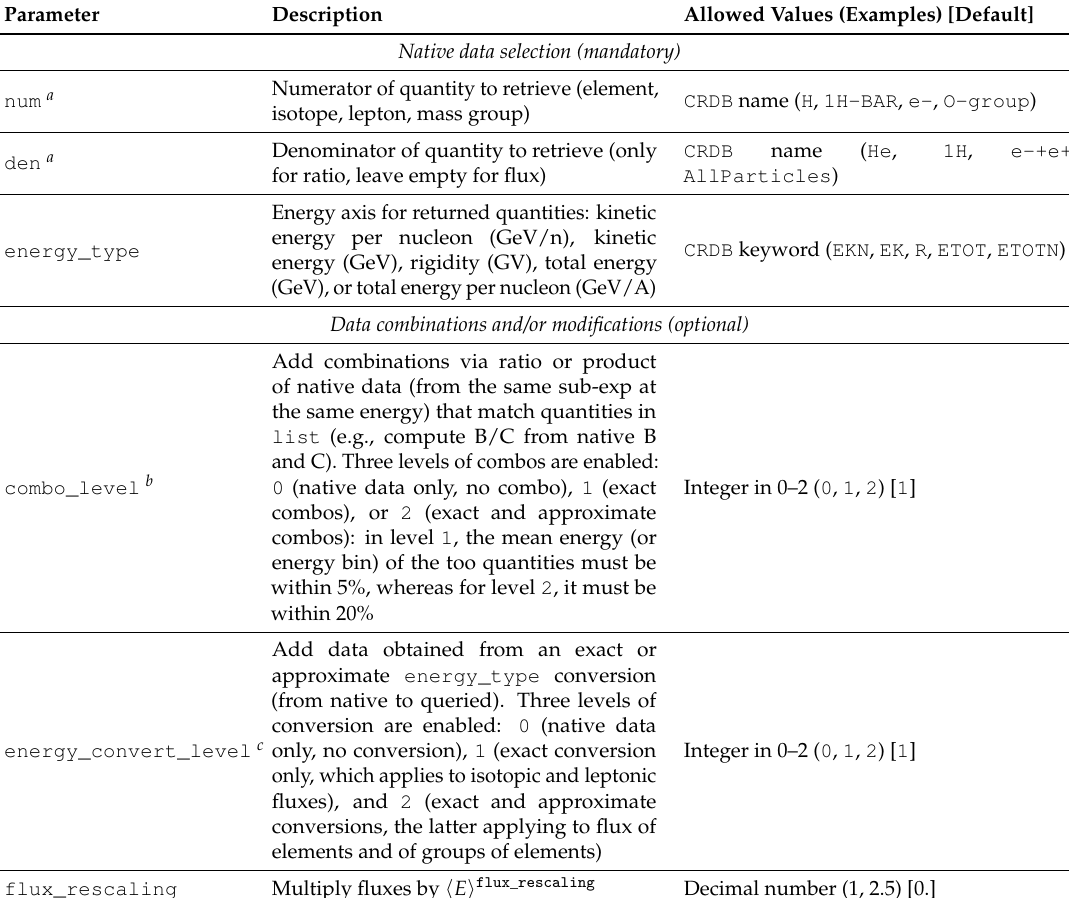
Table 1. REST interface parameters, description, and examples values. Only the first three parameters are mandatory. See text for how to use REST in a command